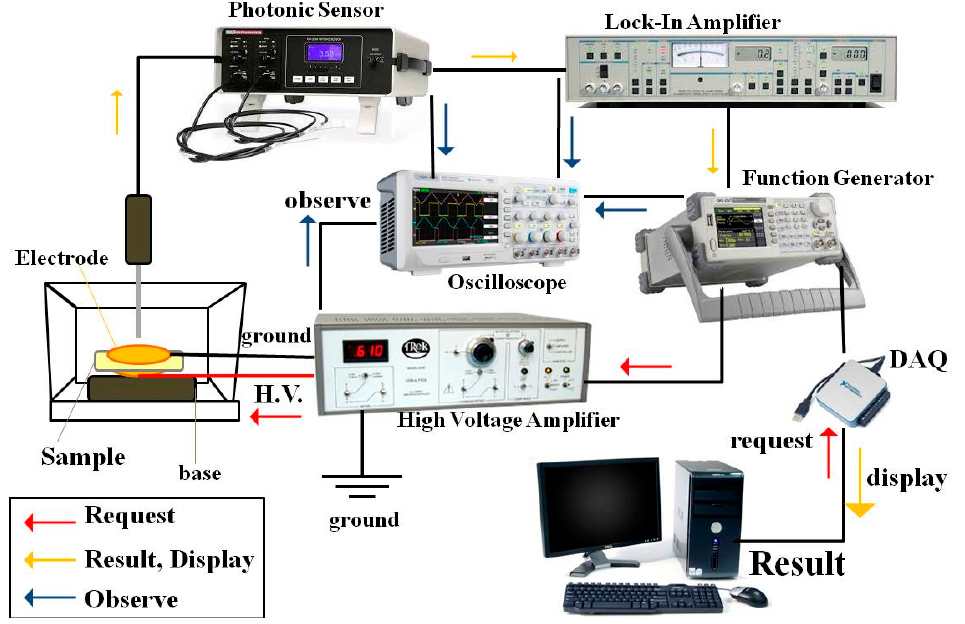
Figure 2. The electrostriction setup.